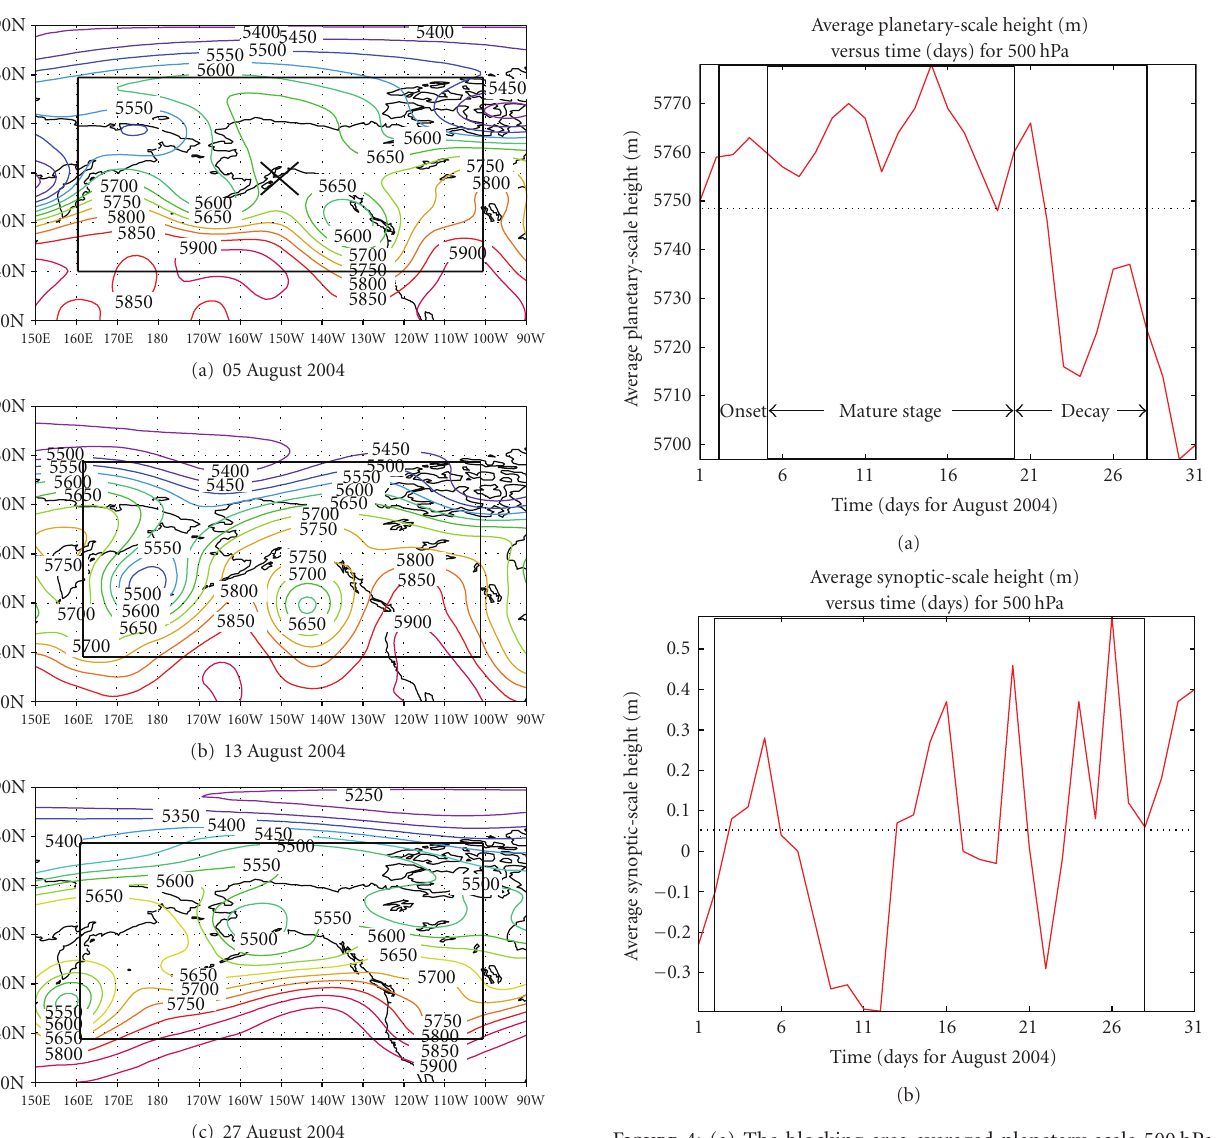
Figure 4: (a) The blocking area averaged planetary-scale 500hPa height (m) versus time (days), for a stationary box (40 ◦ N to 80 ◦ N and 160 ◦ E to 260 ◦ E), in the midlatitude northern hemispheric flow. The dashed dotted horizontal line defines the monthly mean value for the planetary-scale height. The left vertical line marks the beginning, whereas the right vertical line marks the end of the selected blocking event; (b) same as Figure 4a except for the synoptic-scale